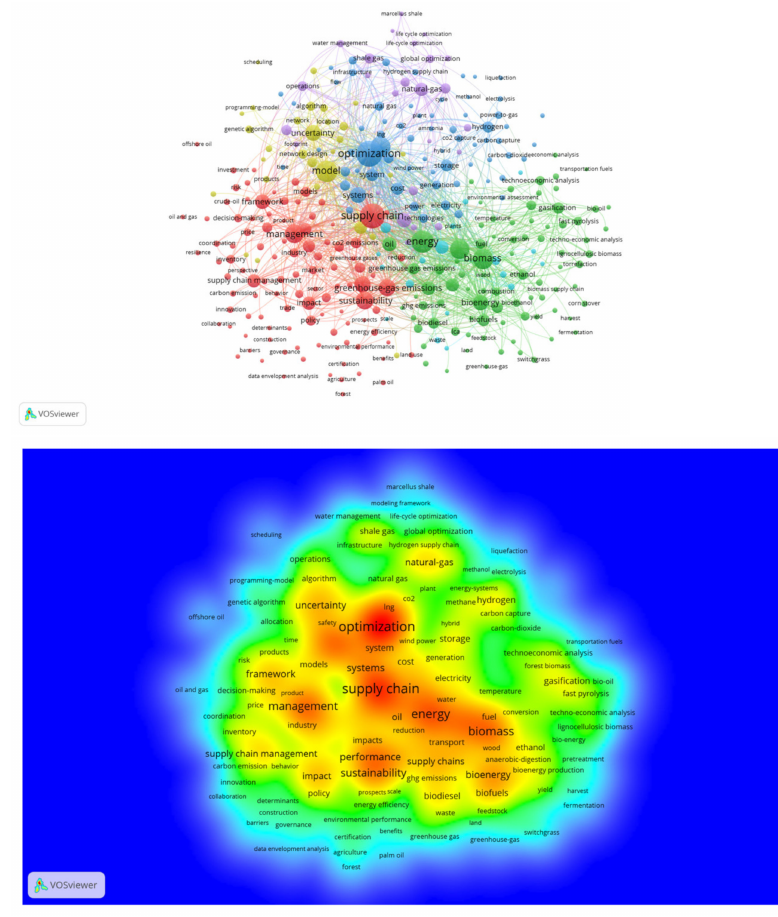
Figure 6. Co-occurrence map of the